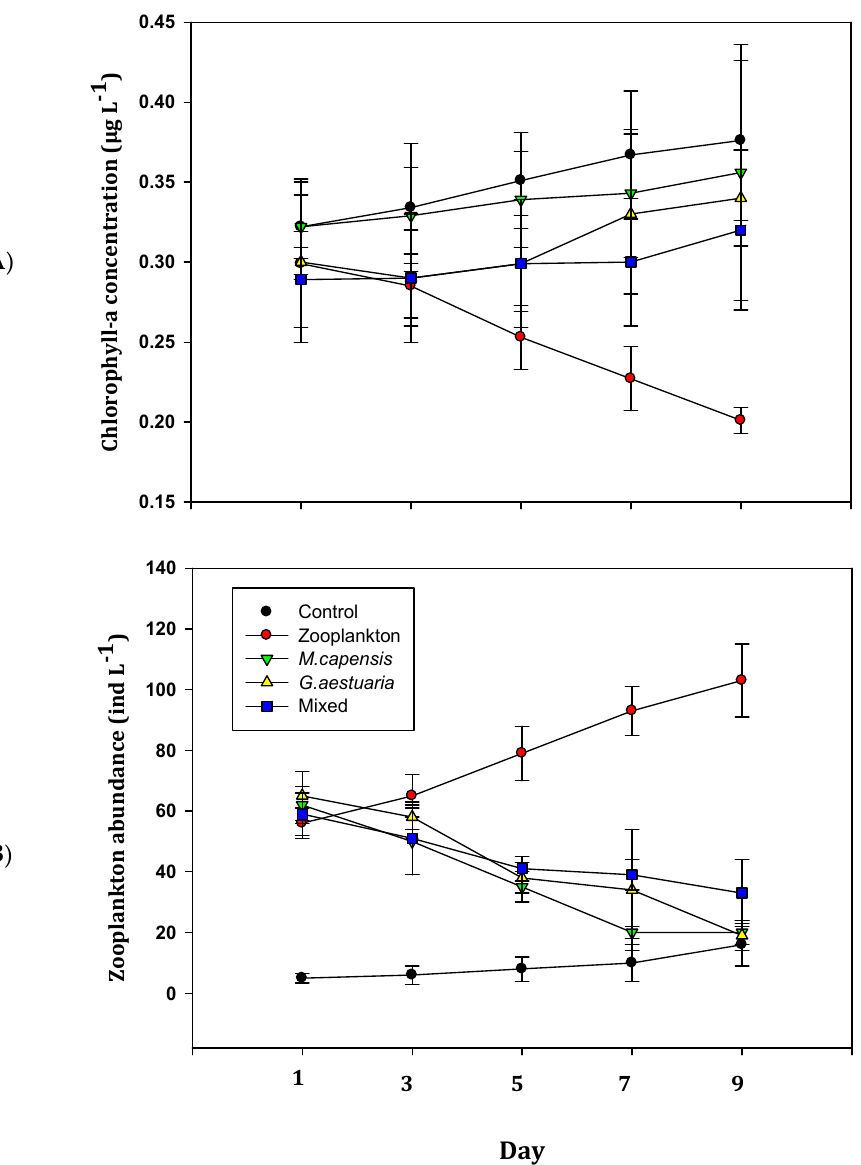
Figure 3. Total chlorophyll- a concentration ( A ) and total zooplankton abundances ( B ) in the differ- ent treatments during the 9-day mesocosm study conducted in the warm temperate, temporarily open/closed Kasouga Estuary, South Africa. Error bars are standard deviation (n = 3 for each treat- ment). Note the different scales on the y-axes.